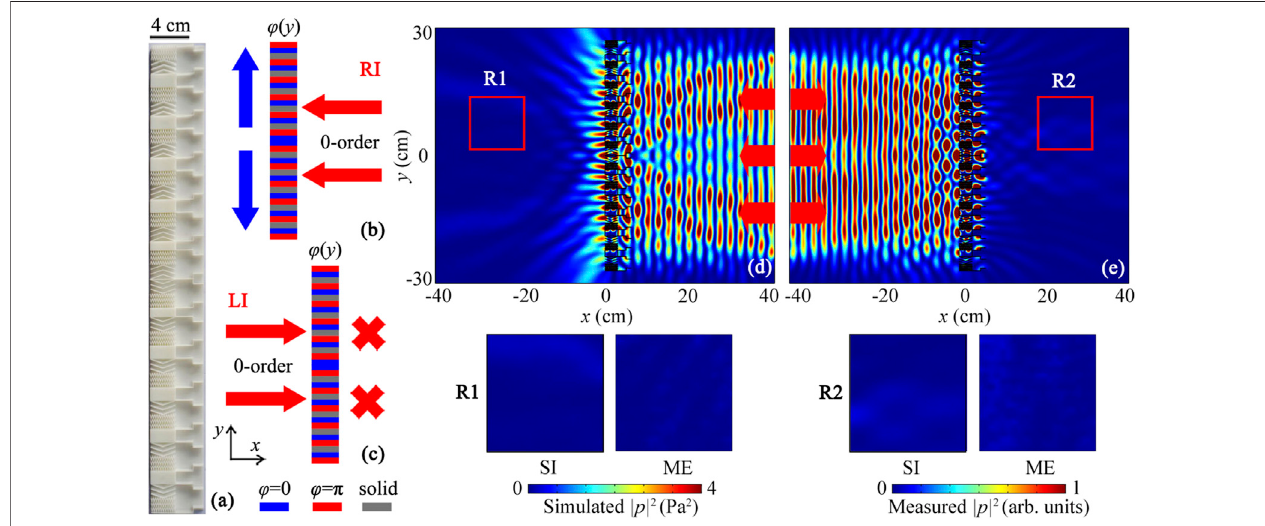
FIGURE3|(A) PhotographoftheBAIlenscomposed of12phased units. Thesolidparts areepoxyresinwhichisused toconnectthephased units. Schematicof propagation paths through the BAI lens under the incidence of the zero-order wave for (B) RI and (C) LI. Simulated intensity distributions created by the BAI lens under the incidence of the zero-order wave for (D) RI and (E) LI at 7.1 kHz. Red solid arrows in (B – E) are the zero-order wave. Four insets on the bottom are the simulated (SI) and measured (ME) intensity distributions in red open squares R1 and R2.